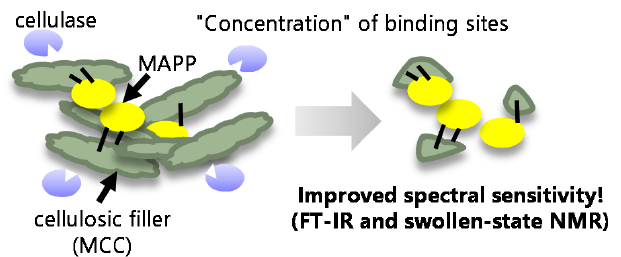
Figure 3. Enrichment of binding site of cellulosic filler and MAPP, and improvement of spectral sensitivity. Reproduced from Ref. [2]. Copyright Elsevier Ltd. (2019).